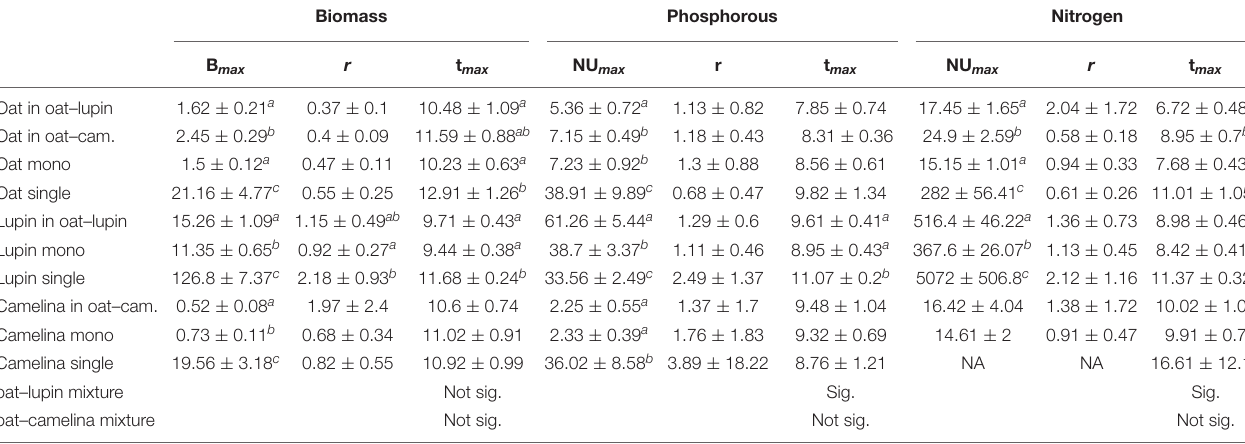
TABLE 1 | Mean values ± SE ( n = 3) of model parameters fitted to logistic accumulation curves in Eq. 1 using a nls model for biomass accumulation, N and P uptake. Biomass Phosphorous